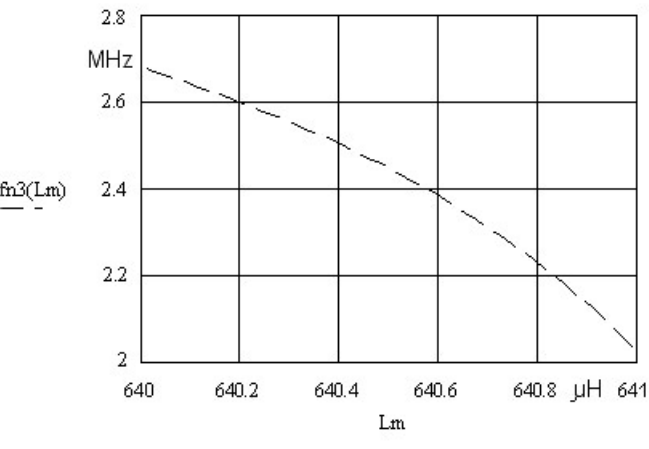
(35 up to 55 pF) at constant value f